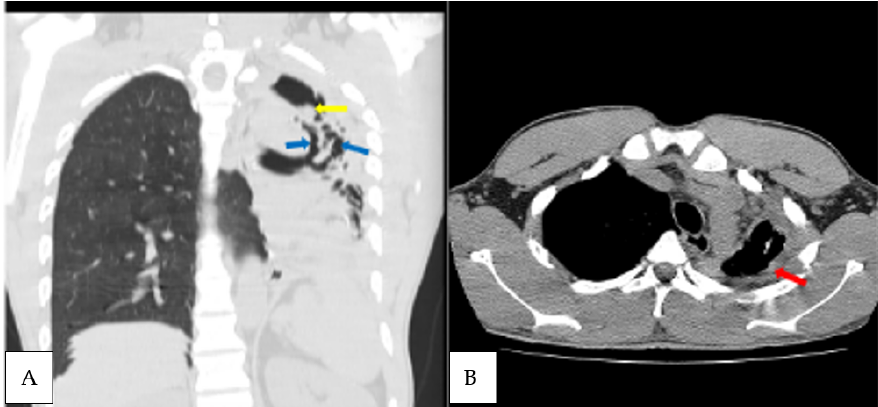
Figure 2. Axial non contrast CT scan, coronal reformatted lung, and axial mediastinal windows of the chest of the patient diagnosed with CPA at T 1 ( A ). Extensive left lung traction bronchiectasis (blue arrows) with ipsilateral lung volume loss, left apical lung cavity with intracavitary material (yellow arrow); ( B ) left apical lung pericavitary pleural thickening (red arrow).